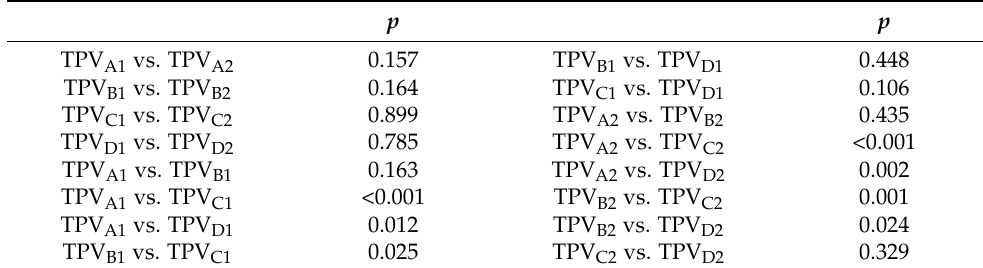
Table 7. Differences in the TPV in different periods.